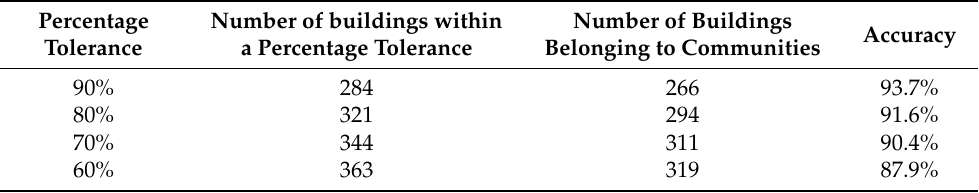
Table 4. The accuracy of buildings intersected with the boundary with percentage tolerance.